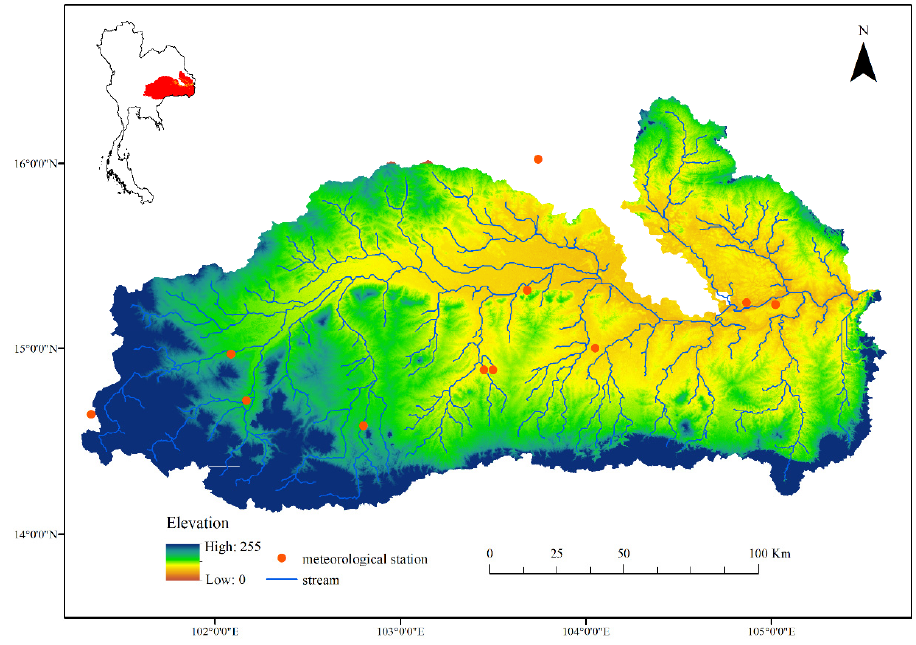
Figure 1. Location of the Mun River Basin based on digital elevation mode (DEM) and the geographic distribution of the 11 meteorological stations.